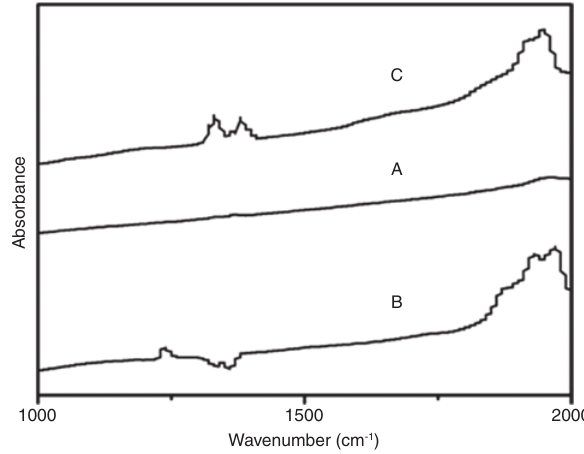
Figure 3: FTIR spectra of (A) unmodified CNTs, (B) functionalized CNTs, and (C) CNTs grafted with fluoropolymers.